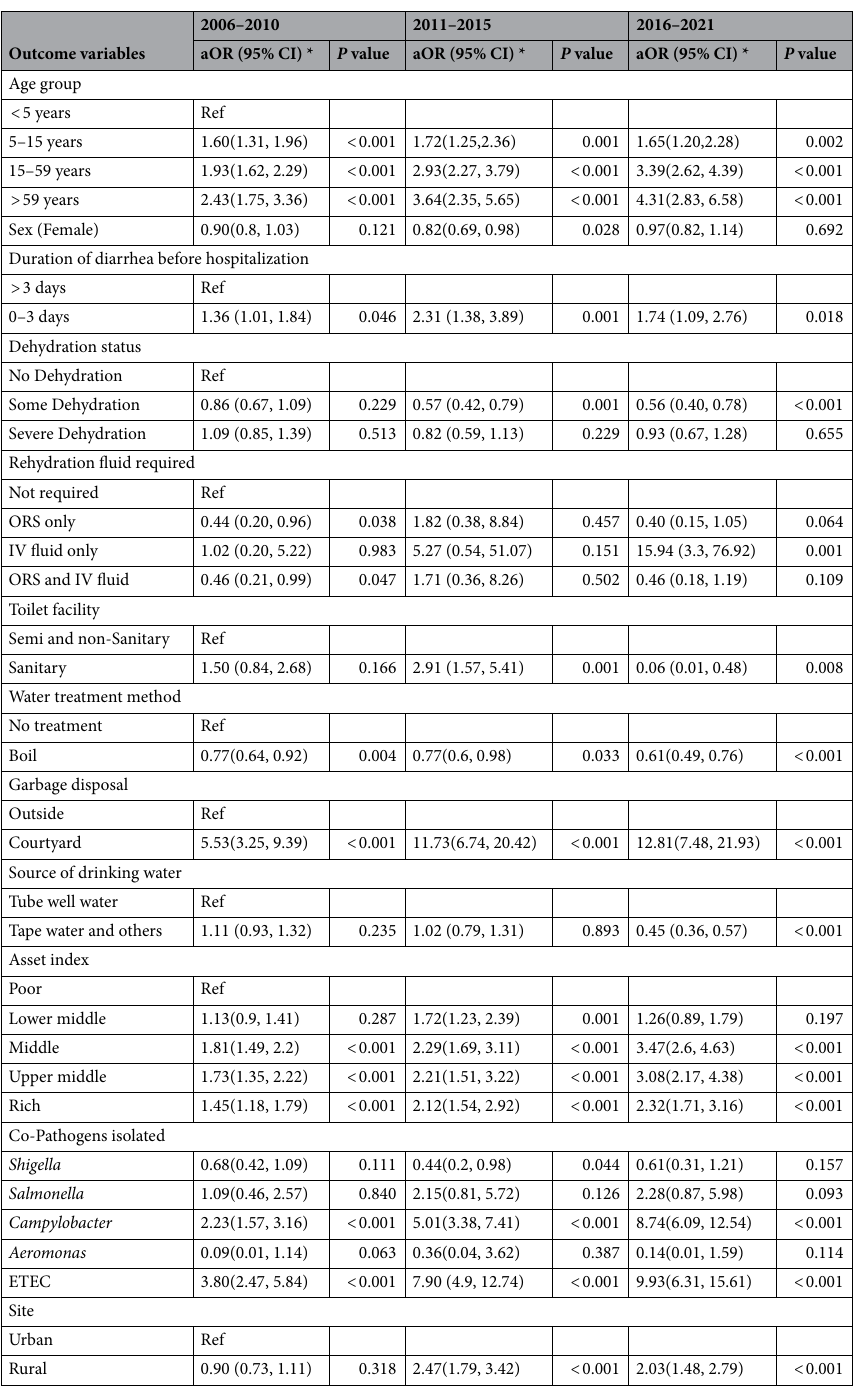
Table 1. Multiple logistic regression analysis results indicating characteristics of the V. cholerae positive diarrhea patients admitted in 2000–2005 while compared with 2006–2010, 2011–2015 and 2016–2021 admission years, in icddr,b Dhaka Hospital (urban) and Matlab Hospital (rural), Bangladesh. *Logistic regression was used on several outcome variables with the year of patient admission as exposure variables where the 2000–2005 group as the reference group and adjusted for patient’s age, sex, the status of breastfeeding (under 3 children), use of antibiotic prior to hospitalization, number of family members, parental education, drinking water, toilet facility, water treatment method, garbage disposal method, asset index and urban & rural sites. Separate models were performed to see the association of characteristics of the V. cholerae -positive diarrhea patients admitted in 2000–2005 while compared with 2006–2010, 2011- 2015, and 2016–2021 admission years in both urban and rural facilities. aOR adjusted odds ratio, Ref. Reference, ETEC. Enterotoxigenic